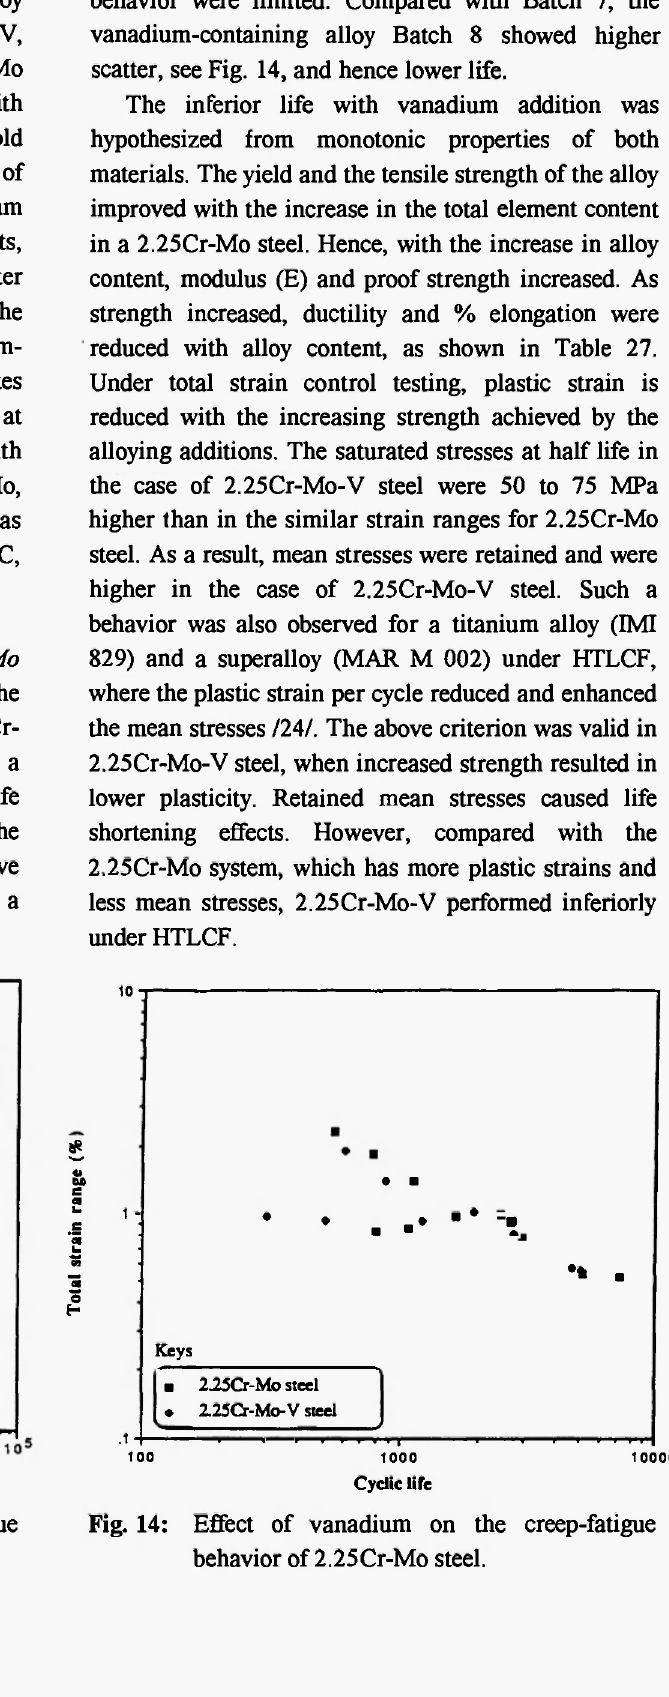
Fig. 13: Effect of composition on the creep-fatigue behavior of low alloy steels.